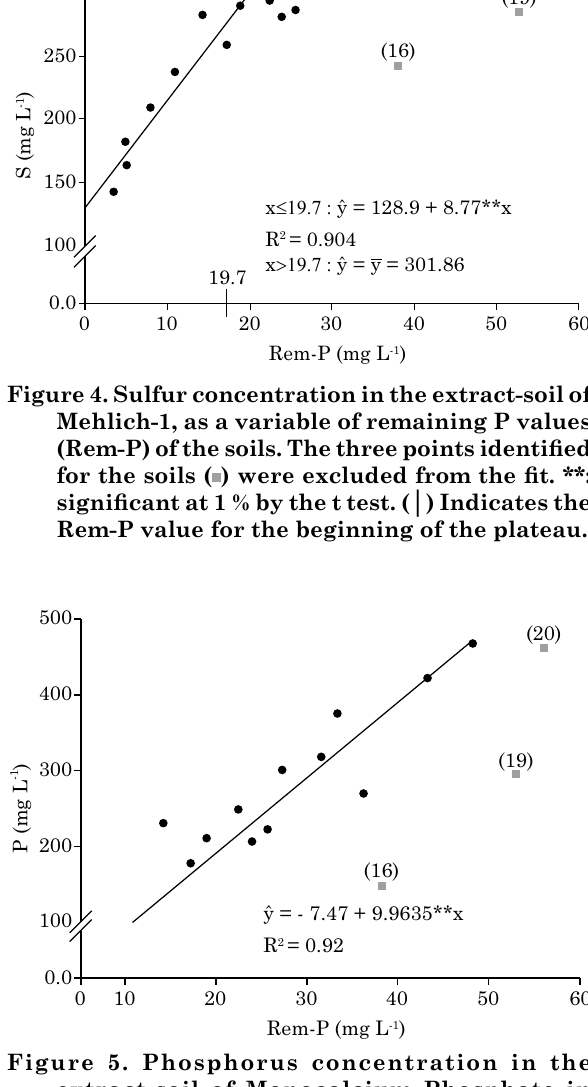
figure 5. p hosphorus concentration in the extract-soil of Monocalcium phosphate in acetic acid as a variable of remaining p values (Rem-P) of the soils. The three points identified for the soils ( ) were excluded from the fit. **: significant at 1 % by the t